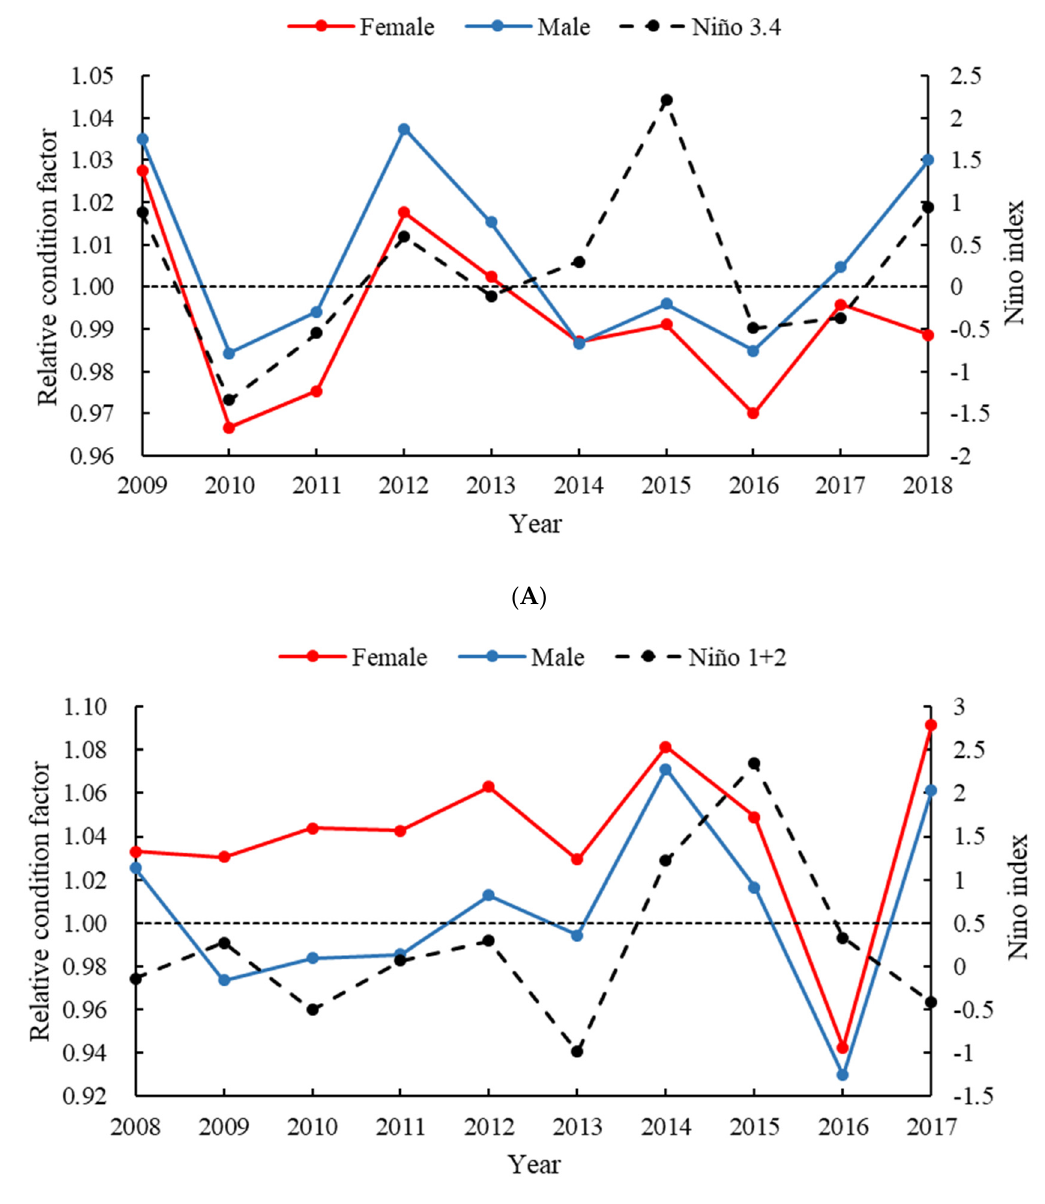
Figure 6. Variation in relative condition factors and Niño index of O. bartramii ( A ) and D. gigas ( B ). The black dot lines show the relative condition factor equal to 1.0.